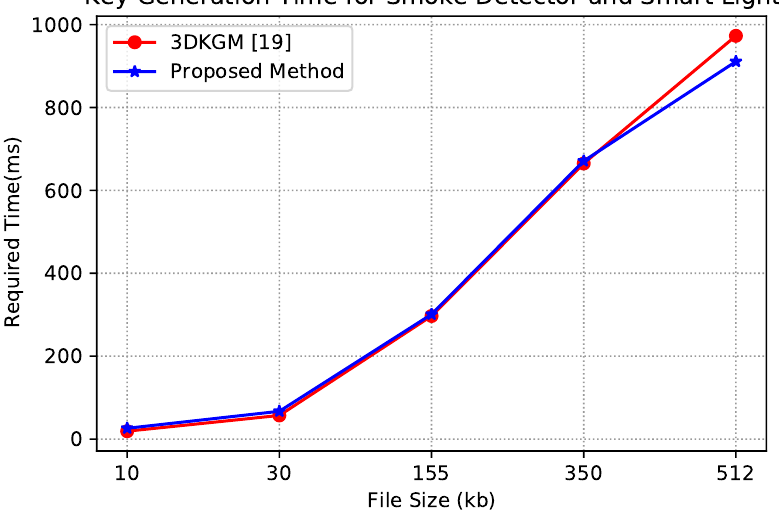
Figure 6. Required time for generating key using 3-dimensional key generation matrix (3DKGM) [6] and the proposed method for the case of smoke detector and smart light based on Tables 2 and